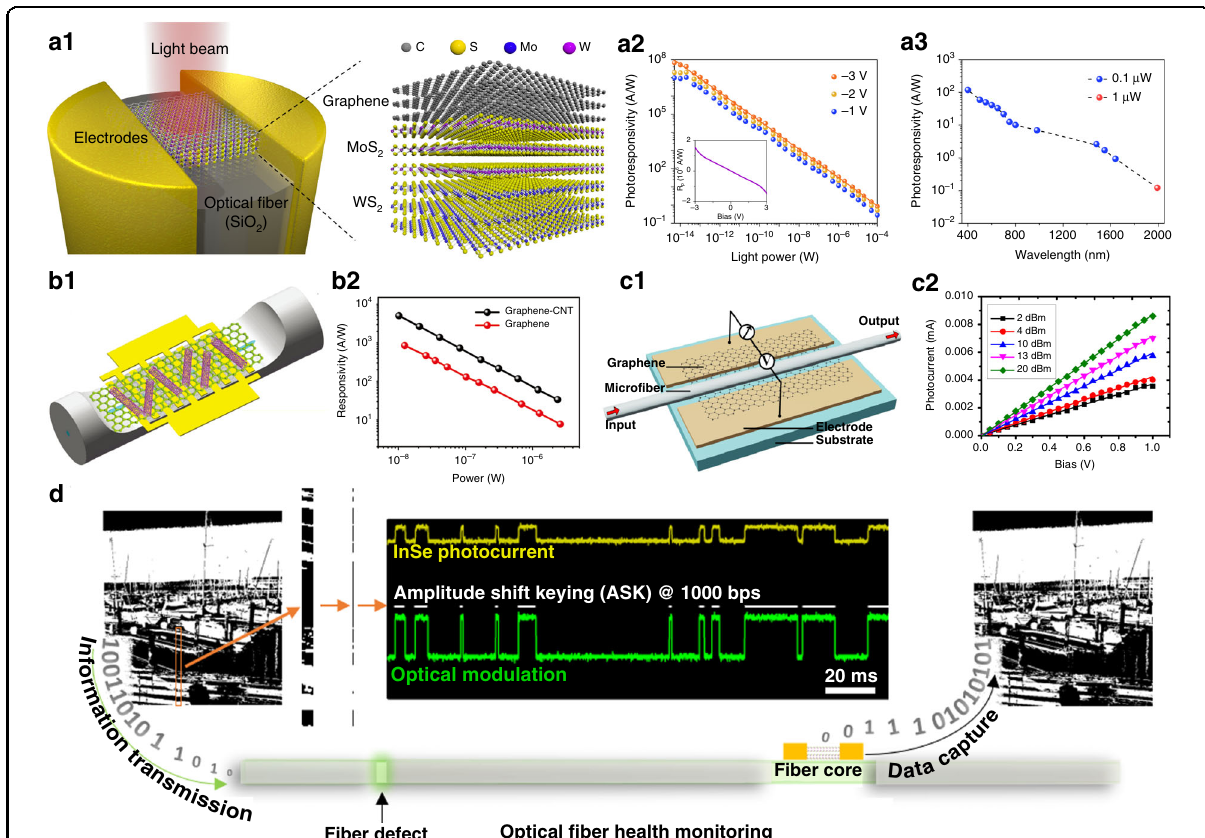
Fig. 6 State-of-the-art all- fi ber photodetectors (FPD) with 2D materials. FPD based on fi ber-endface integrated graphene-MoS 2 -WS 2 heterostructures ( a1 ) for ultrasensitive photodetection ( a2 ) and broadband spectra response ( a3 ) 236 . Schematic of FPD fabricated in DSF with carbon nanotube-graphene heterojunction and interdigitated metal electrodes ( b1 ) for enhanced photodetection ( b2 ) 239 . Schematic of FPD by the micro fi ber- on-graphene structure ( c1 ) and its photocurrent generation with bias voltage ( c2 ) 234 . d Binary image transmitted in an optical fi ber and near- fi eld detected by an InSe FPD deposited on the surface of the multimode fi ber 240 . a1 – a3 Reprinted from ref. 236 . Copyright 2018, Wiley-VCH. b1 – b2 From ref. 239 by the permission of The Royal Society of Chemistry. c1 – c2 Reproduced from ref. 234 with the permission of OSA Publishing. d From ref. 240 . Reprinted by permission from ACS